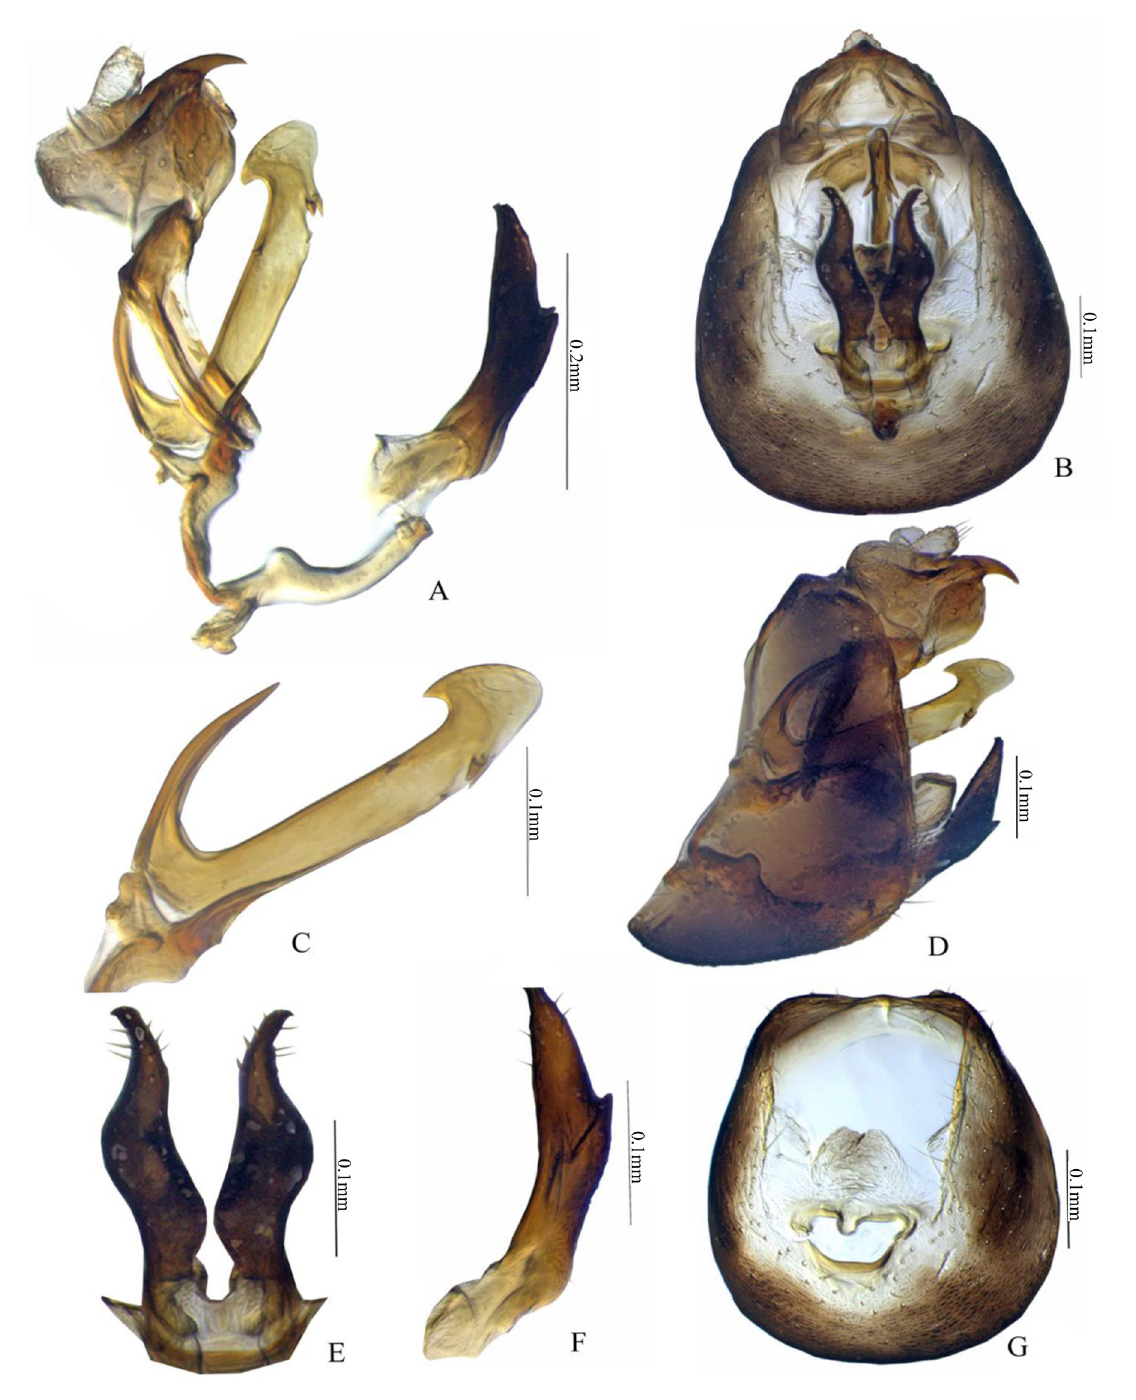
Fig. 4. Eoeurysa sagittaria sp. nov., male genitalia, holotype (NPC HEMT9). A . Aedeagal complex. B . Male genitalia, caudal view. C . Aedeagus. D . Male genitalia, lateral view. E . Parameres, caudal view. F . Paramere, lateral view. G . Pygofer, caudal